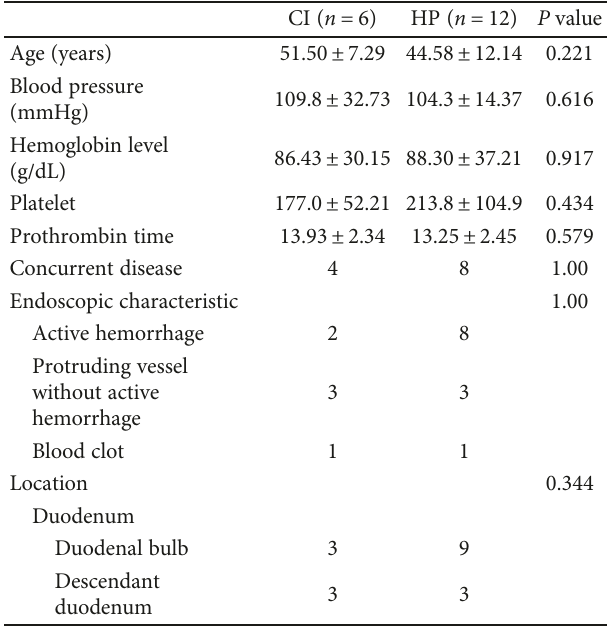
Table 1: Clinical characteristics of patients in the cyanoacrylate injection and hemoclip placement